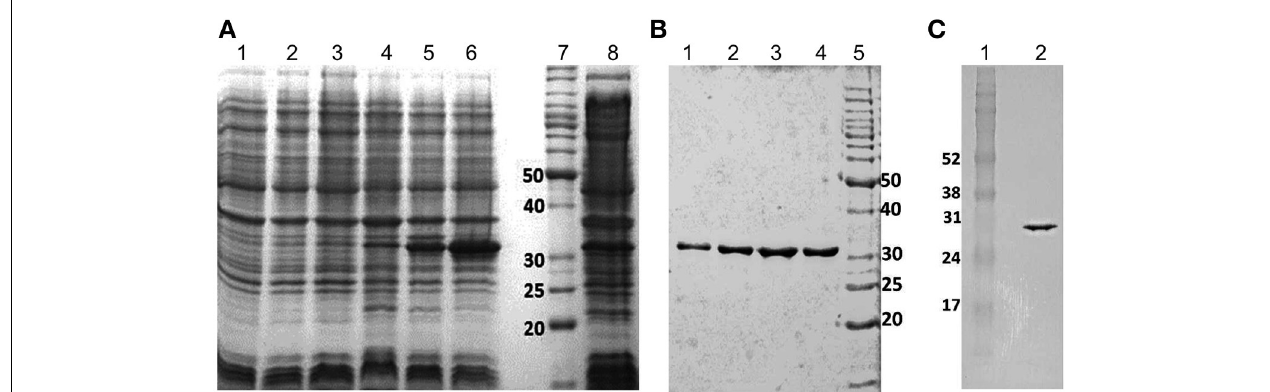
FIGURE 2 | Expression and purification of rSMYB1 as a 6xHis fusion protein. (A) Coomasie blue-stained 12% SDS-PAGE profile of E. coli BL21 expressing the pET28a-SMYB1 construct. Lanes: (1) lysate of induced culture—0h; (2) lysate of induced culture—1h; (3) lysate of induced culture—2h; (4) lysate of induced culture—3h; (5) lysate of induced culture—4h; (6) soluble fraction (SF) of induced culture lysate; (7) molecular weight marker (BenchMark Protein Ladder, Invitrogen); (8) non-soluble